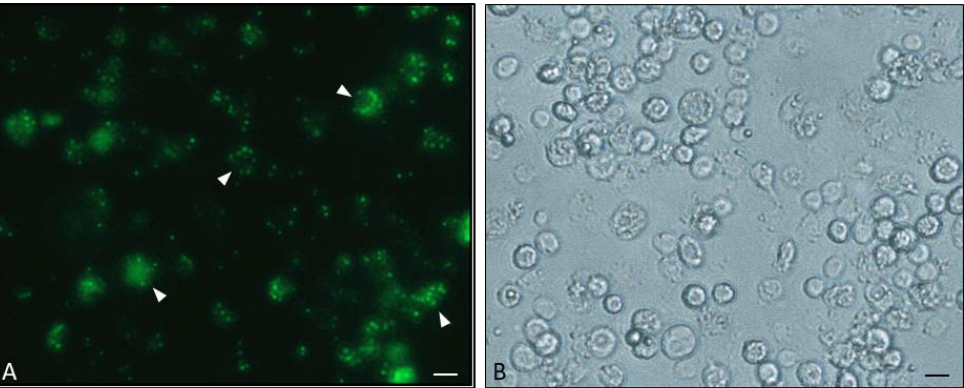
Figure 10. An example of in vitro phagocytosis. ( A ): Fluorescein Isothiocyanate (FITC)-conjugated Escherichia coli cells (arrowheads) are engulfed by lepidopteran hemocytes (he). ( B ): brightfield image. Bars = 50 µ m, (unpublished micrographs by Brivio [86]).